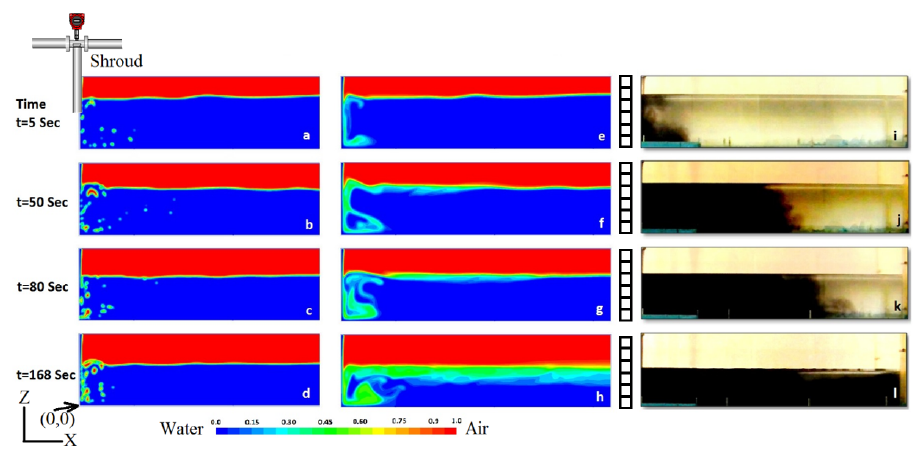
Figure 3. Interface and mixing snapshot obtained by ( a – d ) Geo-reconstruct scheme ( e – f ) Modified-HRIC scheme and ( i – l ) experiment.